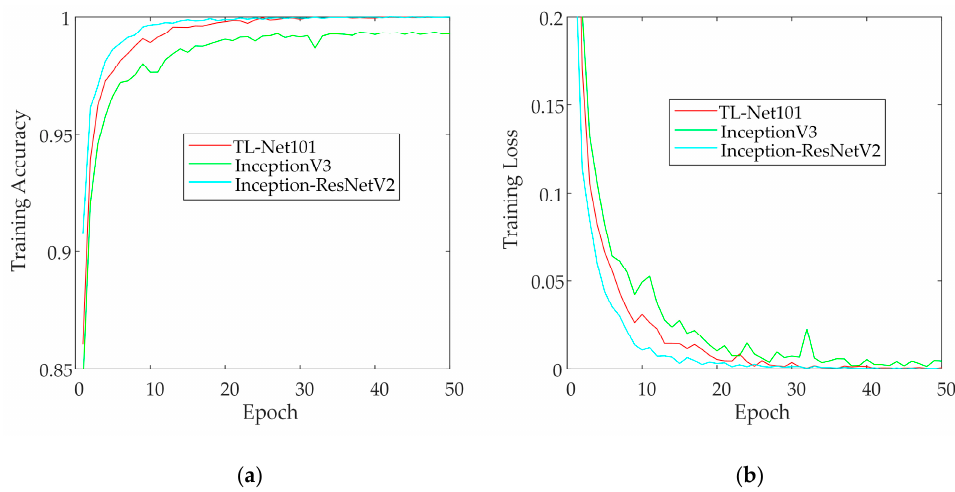
Figure 12. ( a ) The training accuracy curves of ResNet101 and TL-Net101; ( b ) the training loss curves of ResNet101 and TL-Net101 .